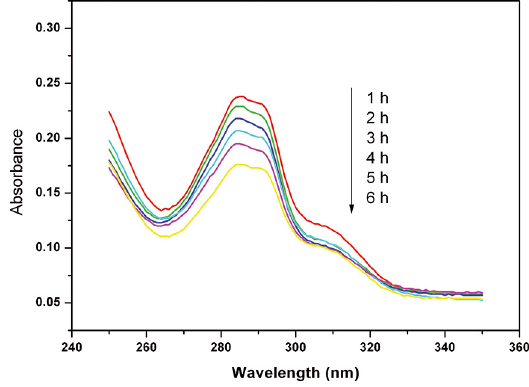
Figure S3: UV-vis spectral changes of 2,4-dichlorophenol in aqueous Cu (OH)PO (H-1) sample as a function of irradiation 2 4